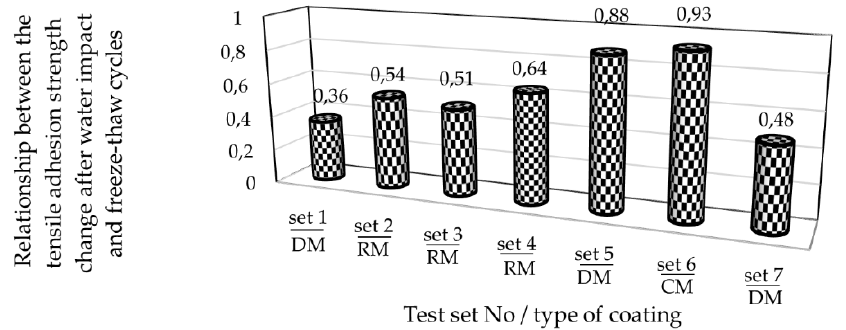
Figure 6. Relationship between the tensile adhesion strength change in the set, following water impact and freeze/thaw cycles, determined as a quotient of these two values.